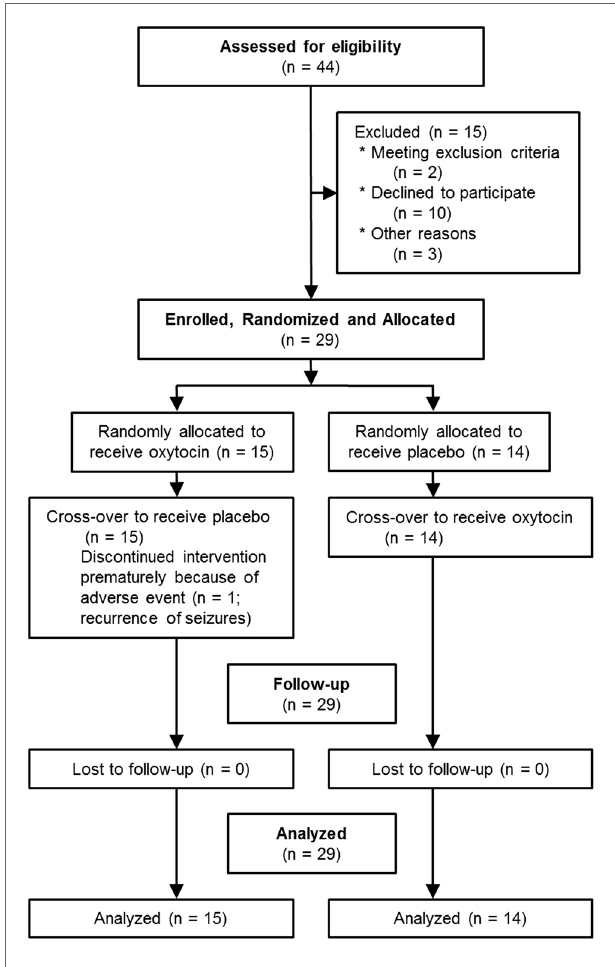
FigUre 2 | cOnsOrT 2010 flow